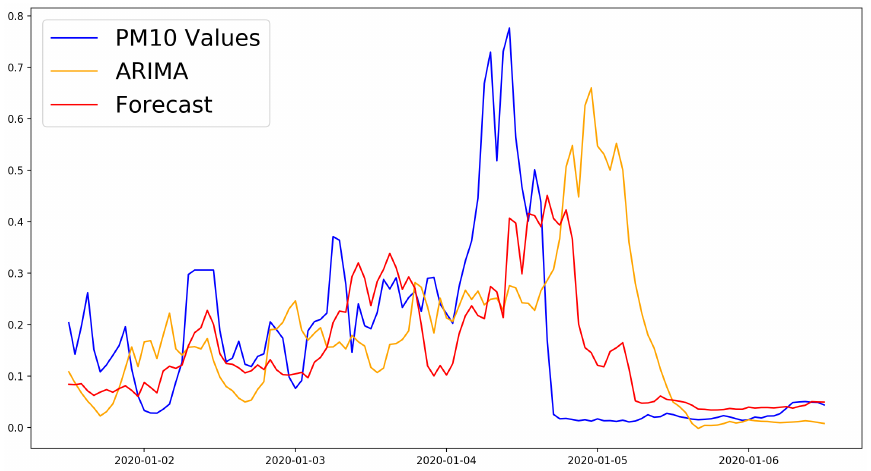
Figure 5. Performance comparison to the ARIMA model of the LSTM + Dense model with the best forecasting performance with the 12 h time